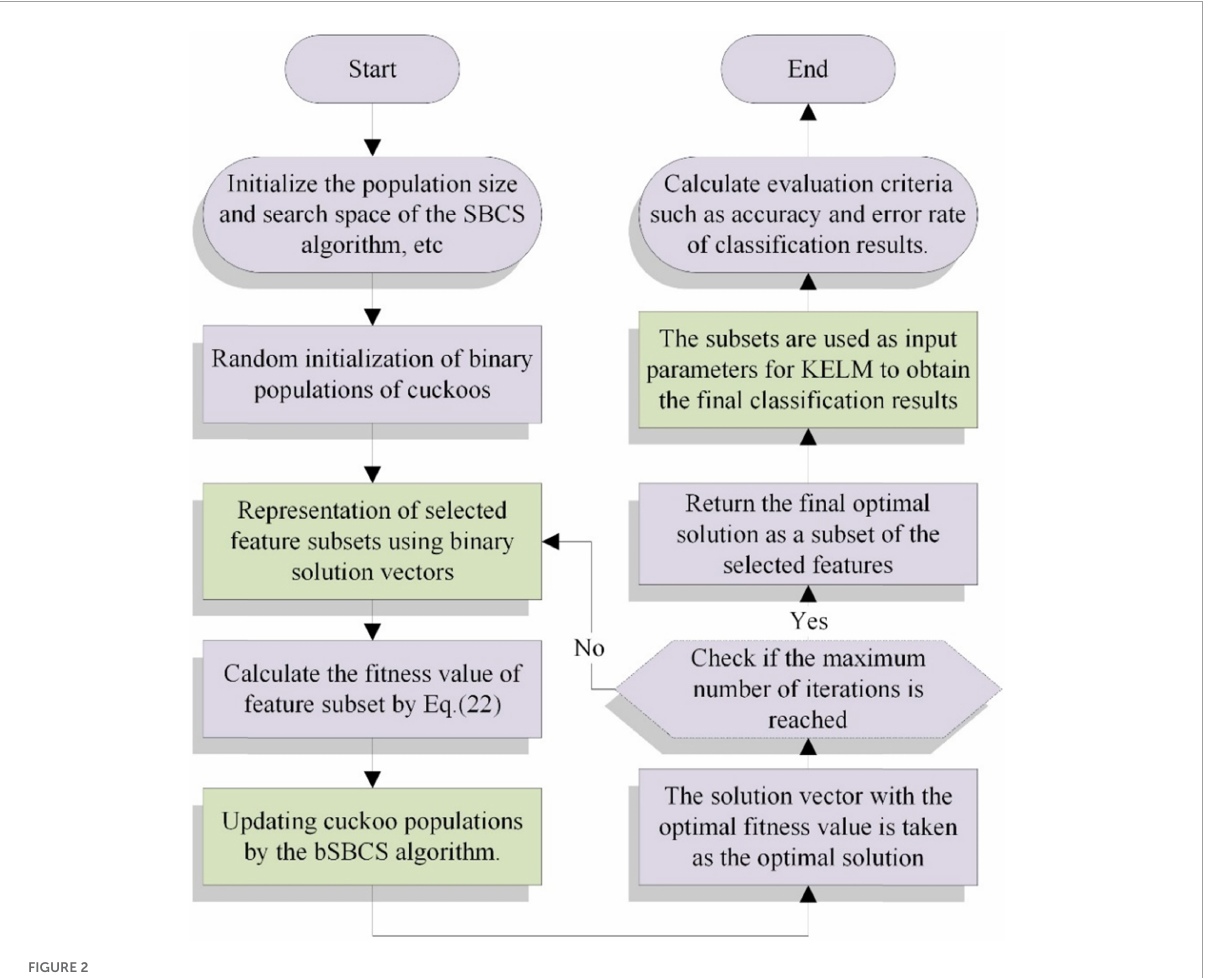
FIGURE2 Flowchart of